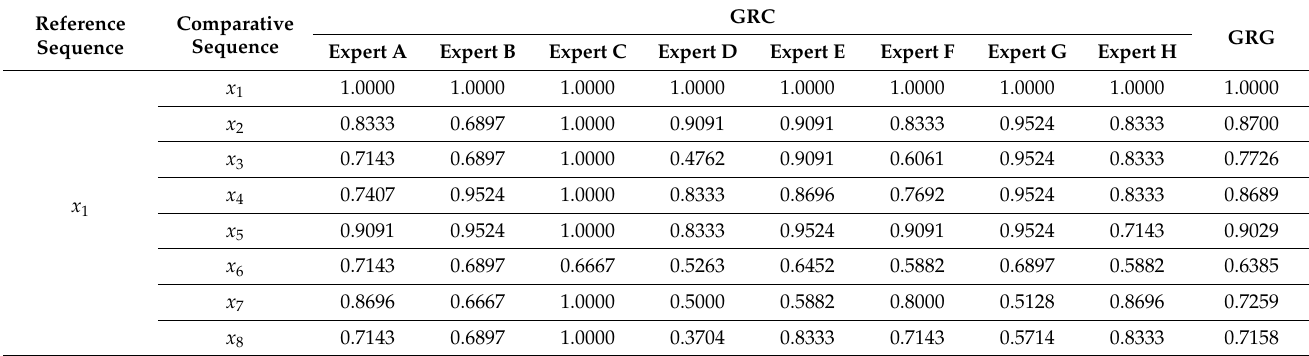
Table A1. Calculating the grey relational grade (GRG) by treating xi as the reference